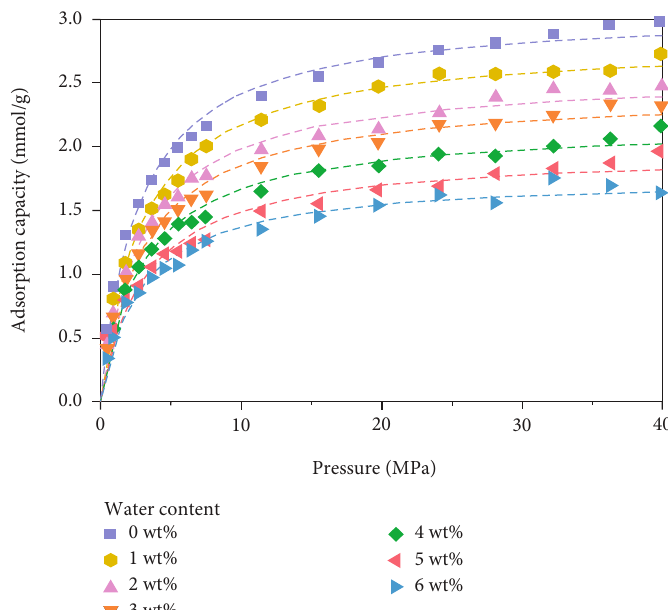
Figure 5: CH adsorption isotherms under di ff erent water contents at 338.15 K. Points are results of simulation, and lines are results of 4 Langmuir fi tting [20].